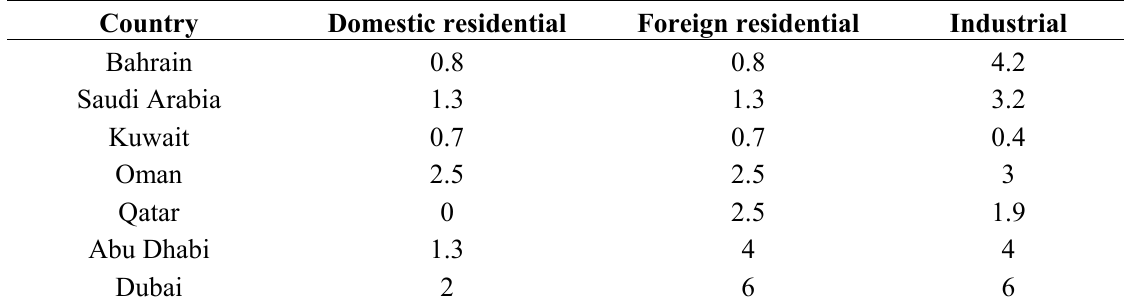
Table 1. Average electricity prices in the Gulf Cooperation Council (GCC) countries 2011, US$/kWh. Sources: